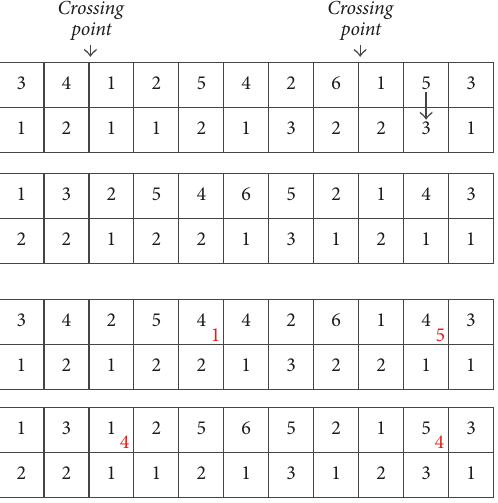
Figure 7: The process of crossover.